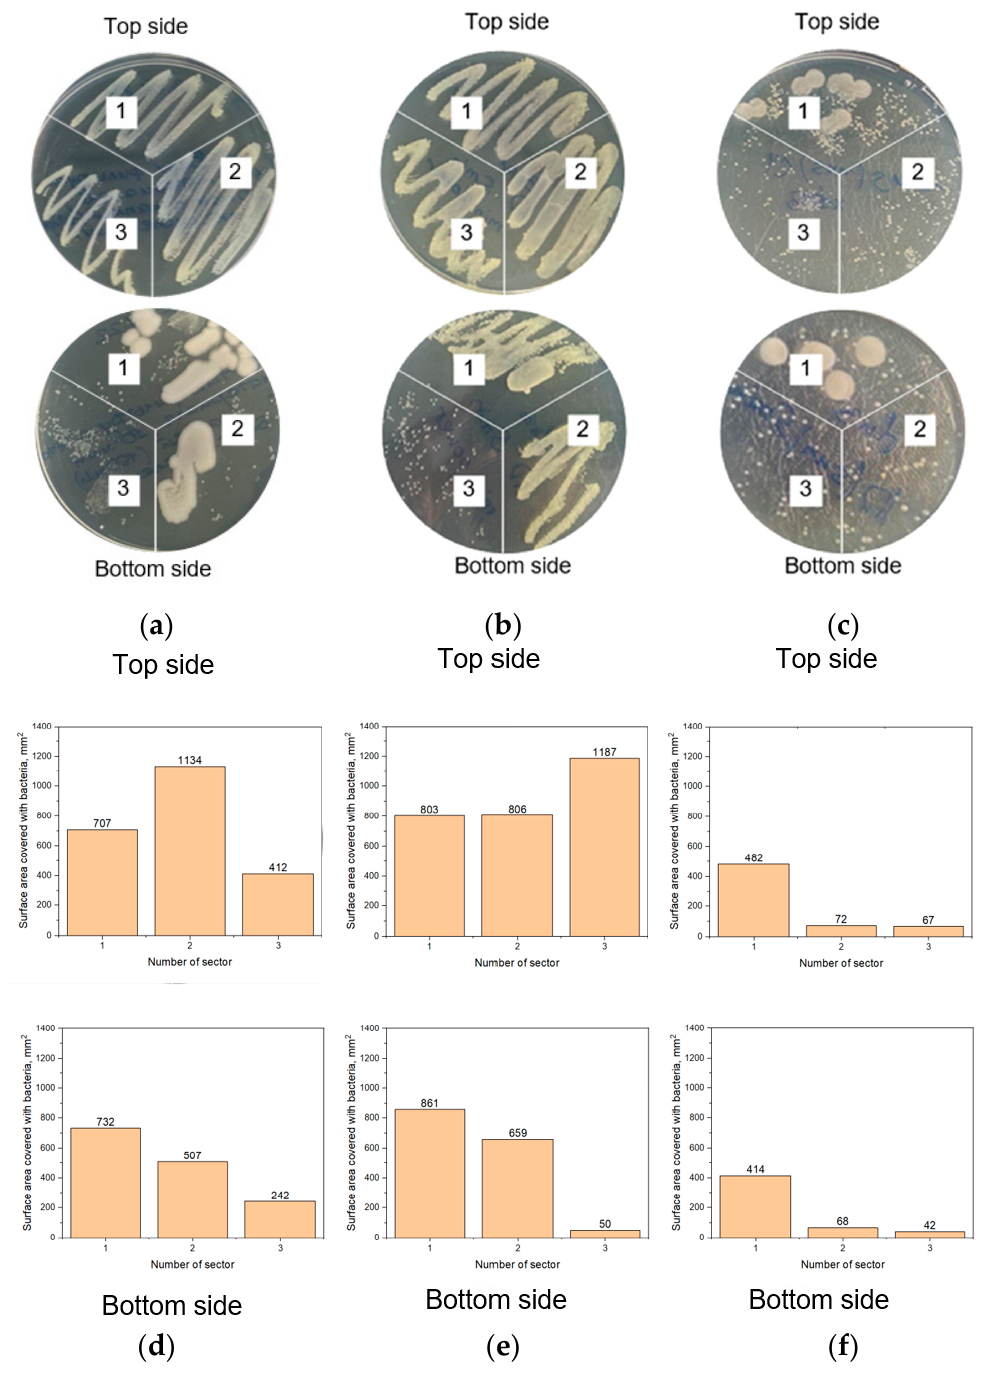
Figure 7. The top views of the Petri dishes filled with agar gel and cultured bacteria wash-swabbed from the filtering materials subjected to dropping the bacterial suspension on the top side ( a ) before the light exposure, ( b ) after the LED projector exposure for 30 min and ( c ) after the sunlight exposure for 30 min. Sector #1—the medical face mask filter, sector #2—the prototype made of TiO 2 /Ag/polymer membrane on the medical face mask filter, sector #3—the TiO 2 /Ag/polymer membrane: ( d – f )—histograms of surface area of the Petri dish sectors covered with bacteria, which correspond to ( a – c ) photos.